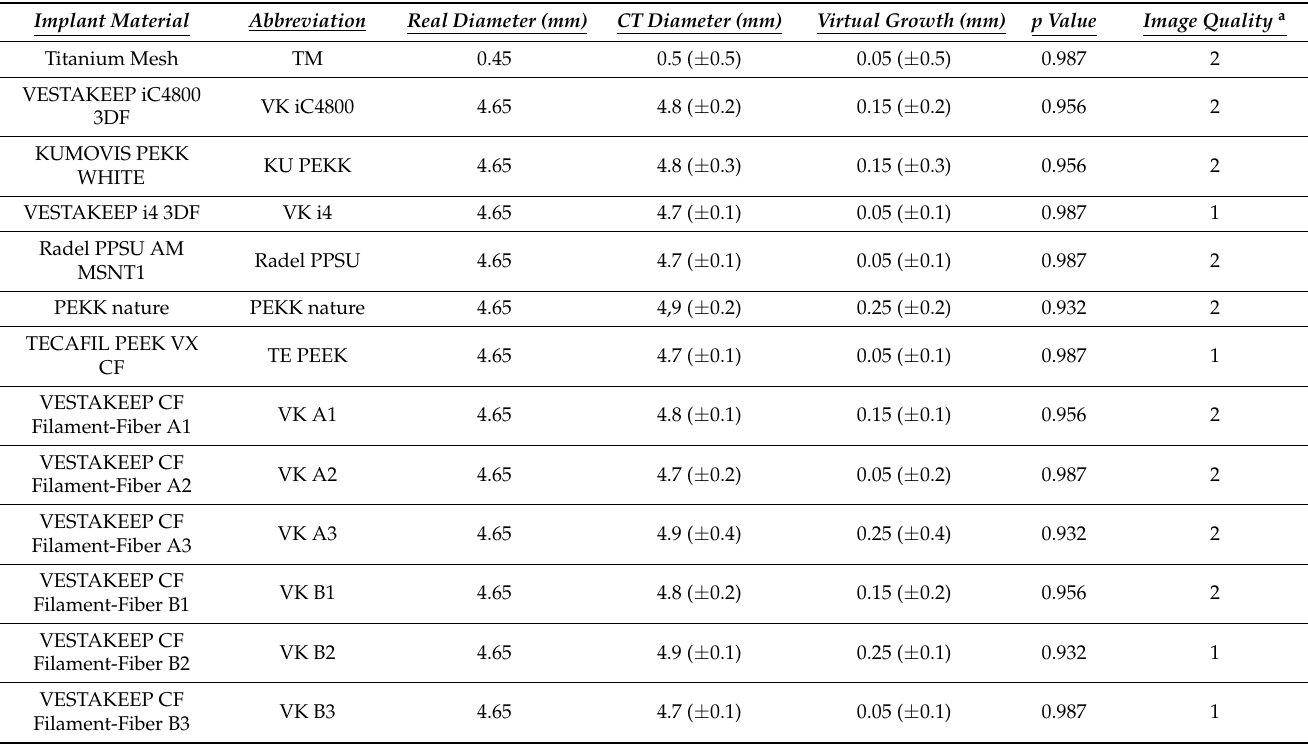
Table 3. Display of implant materials, comparison of real implant diameter (mm) and CT diameter (mm) as virtual growth (mm) with respective p -values and image